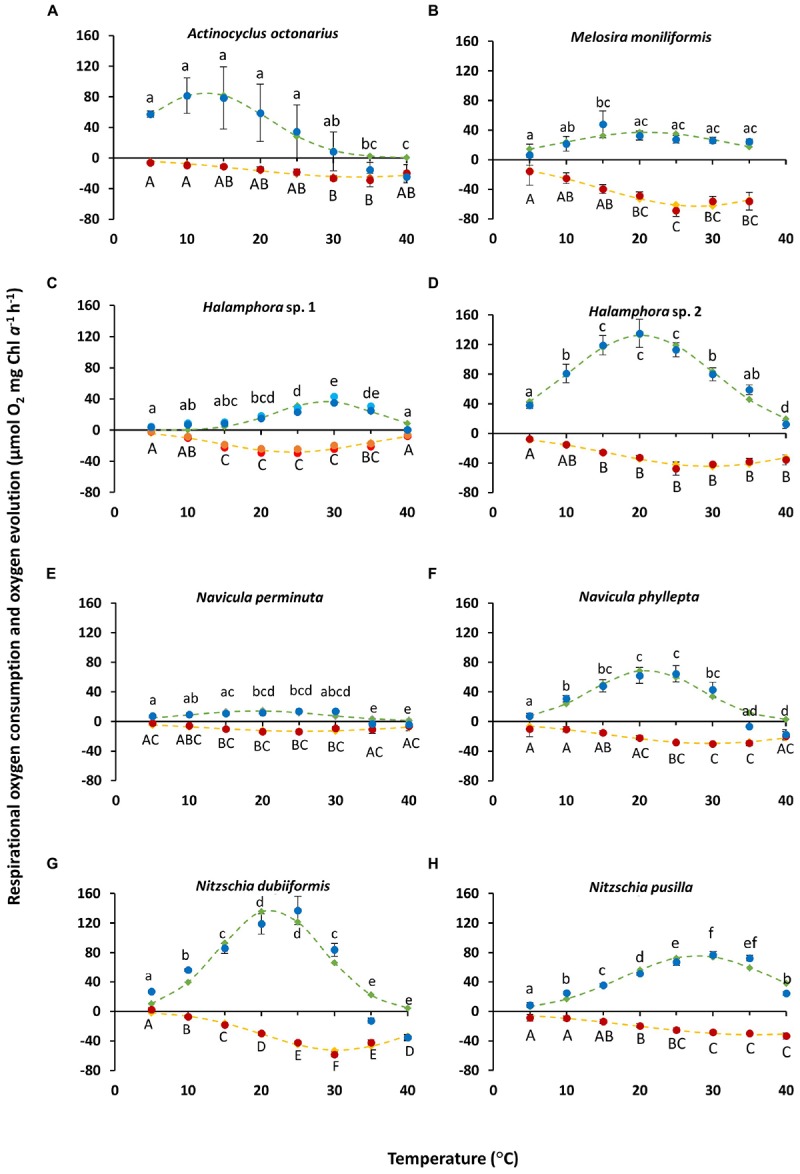
(A–H) Photosynthetic (blue) oxygen evolution at 266 ± 6.7 μmol photons m–2s–1 and respiratory (red) oxygen consumption in darkness of eight different diatom cultures as a function of increasing temperature. The measured data were fitted by the model of Blanchard et al. (1996) (photosynthesis: green dashed line; respiration: yellow dashed line). All cultures were kept in f/2 Baltic Sea water medium, 15SA. Data represent mean values ± SD (n = 3). Different lowercase (photosynthesis) and capital letters (respiration) indicate significantly means (p < 0.05; one-way ANOVA with post hoc Tukey’s test). (A)
Actinocyclus octonarius; (B)
Melosira moniliformis; (C)
Halamphora sp. 1, notice values consist of n = 2 (represented each by different colors), (D)
Halamphora sp. 2; (E)
Navicula perminuta; (F)
Navicula phyllepta; (G)
Nitzschia dubiiformis; (H)
Nitzschia pusilla.